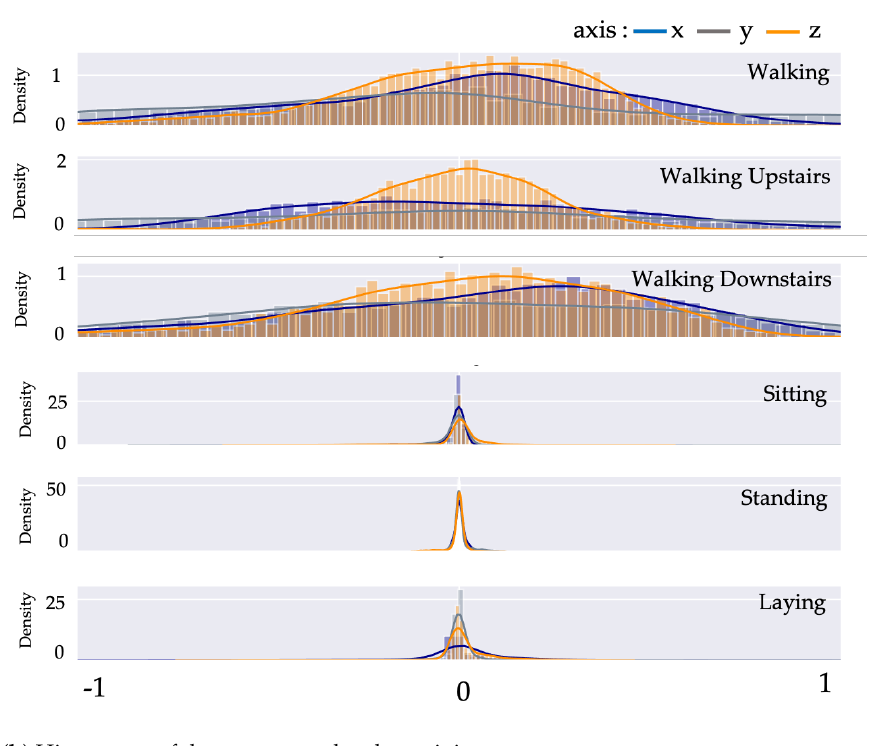
Figure 9. Histograms visualization of data from ( a ) accelerometer ( b )